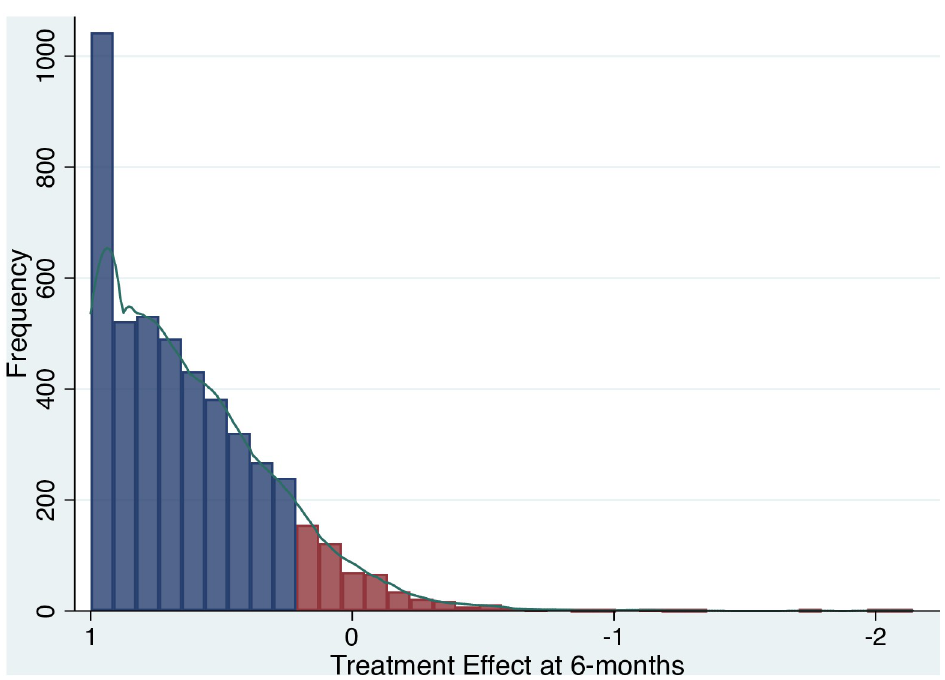
Fig 2. Distribution of the treatment effect score for patients who did, and did not, respond to surgery. Red = poor pain outcome, Blue = good pain outcome.